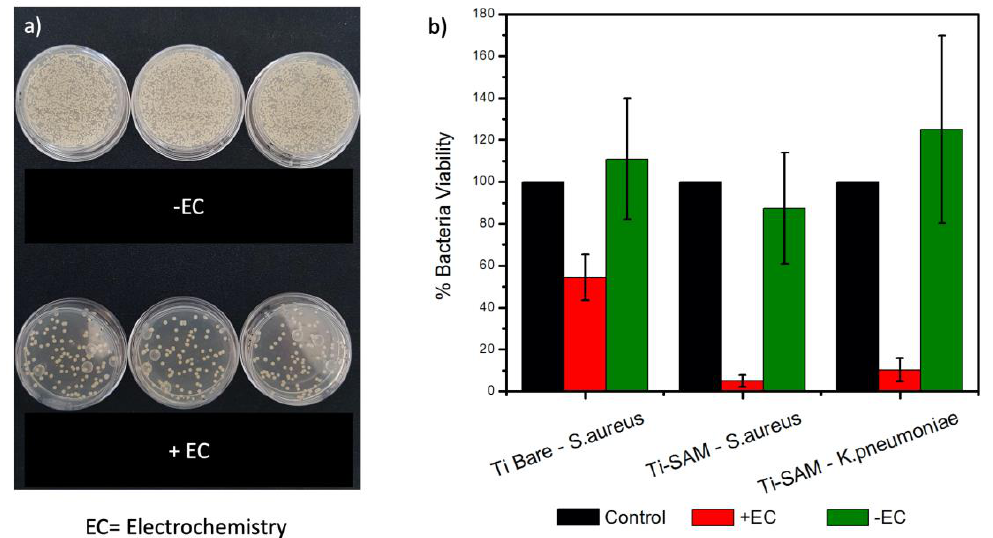
Figure 3. ( a ) Petri dish captions of bacteria culture of S. aureus without ( − EC) and with electrochemical stimuli (+EC). ( b ) Percentage of viability of bacteria on titanium bare surface and SAM-modified Ti (3) upon contact with S. aureus and/or K. pneumoniae with (+EC) and without electrochemical ( − EC) activation.